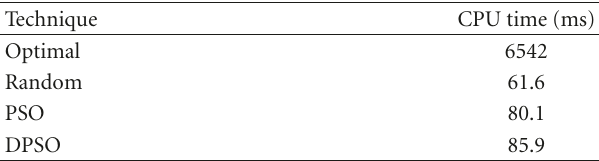
Figure 4: Comparisons of optimal, random and PSO/DPSO PTS- AIC. Adjacent subblock partitioning with N b = 16, N w = 2. Table 2: CPU time of Optimal, random and PSO/DPSO